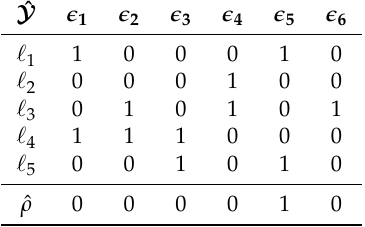
Table 6. Level soft set L ( ˆ Γ ; bb )